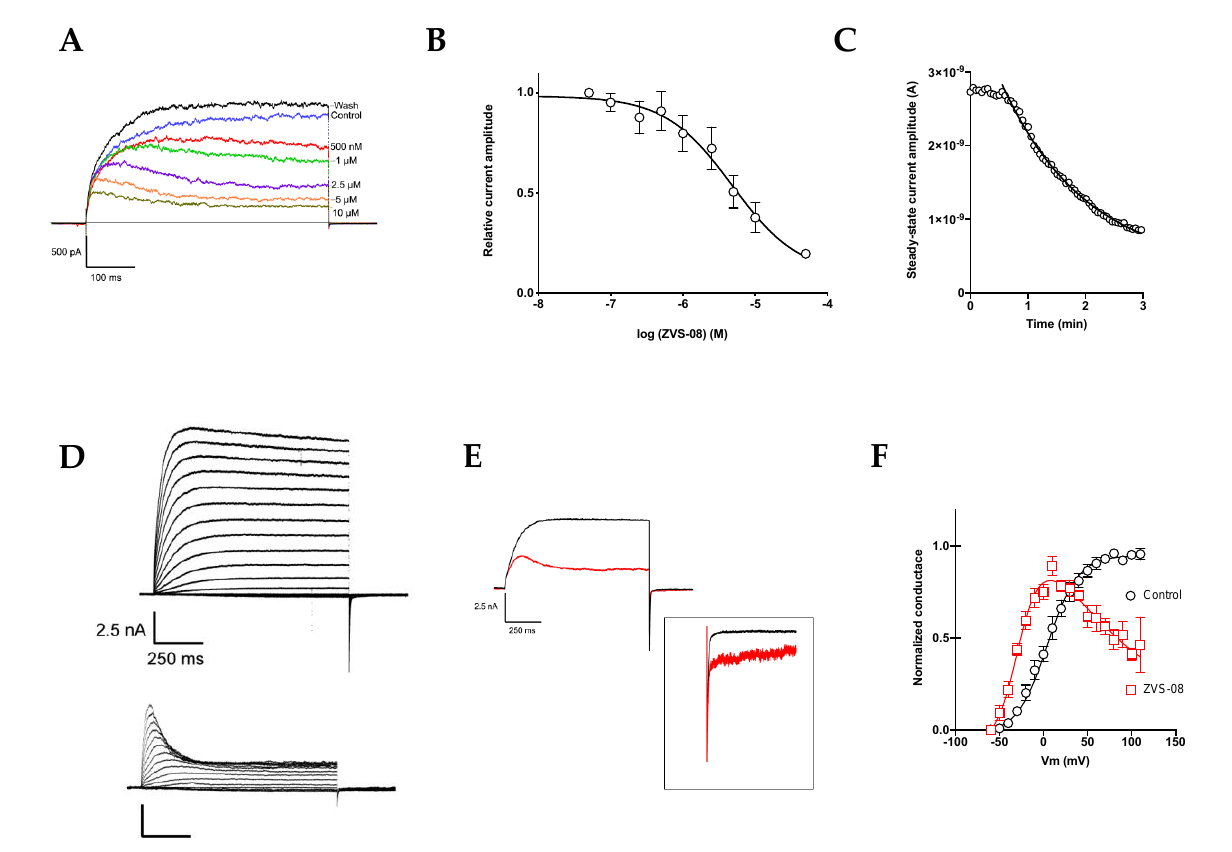
Figure 9. ( A ) Inhibition by different concentrations of ZVS-08 hit compound. ( B ) Dose–response (data from 3–10 independent determinations, mean ± SEM). ( C , D ) Current–voltage relationship in the absence (upper traces) or presence of 5 µM ZVS-08 (lower traces) obtained by depolarisation from a holding potential of −80 mV to potentials ranging between −60 and +100 mV. ( E ) The traces corresponding to depolarisation to +40 mV are superimposed for easier comparison. The inset shows the normalised tail currents to highlight the slower deactivation in the presence of ZVS-08. ( F ) Conductance–voltage relationship in control (black symbols) and in the presence (red symbols) of 5 µM ZVS-08, obtained by biexponential fit to the tail current (at −80 mV) and extrapolation to time 0. The solid lines represent the result of a fit using a Boltzmann distribution with a block at positive voltages. Table 2. Potencies of compounds ZVS-08, 1 and 8 against K V 10.1 and hERG. Compound